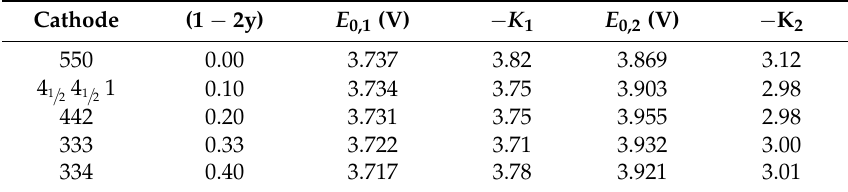
Table 2. Electrochemical parameters of NMC materials calculated from Equation (4) at low rate of C/20. (1 ´ 2y) is the cobalt concentration in the LiNi y Mn y Co 1-2y O 2